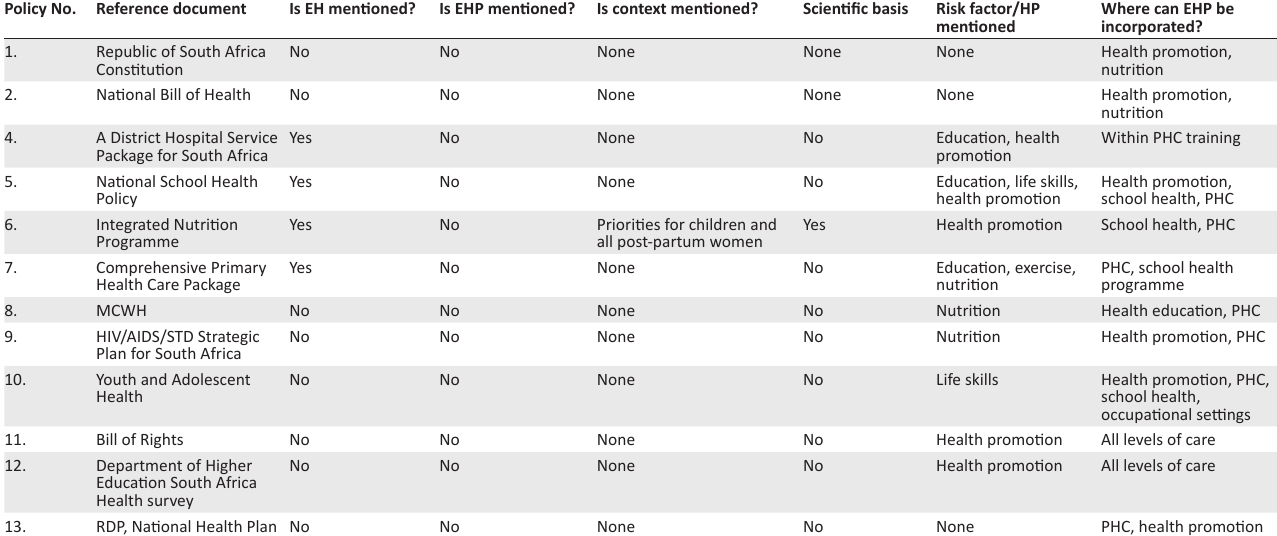
TABLE 5: National policy documents considered for analysis. Policy No. Reference document